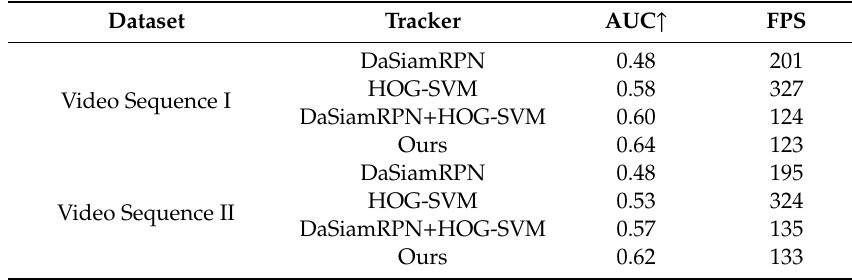
Table 1. Comparison of the tracking speed (fps) and area under the curve (AUC) with di ff erent